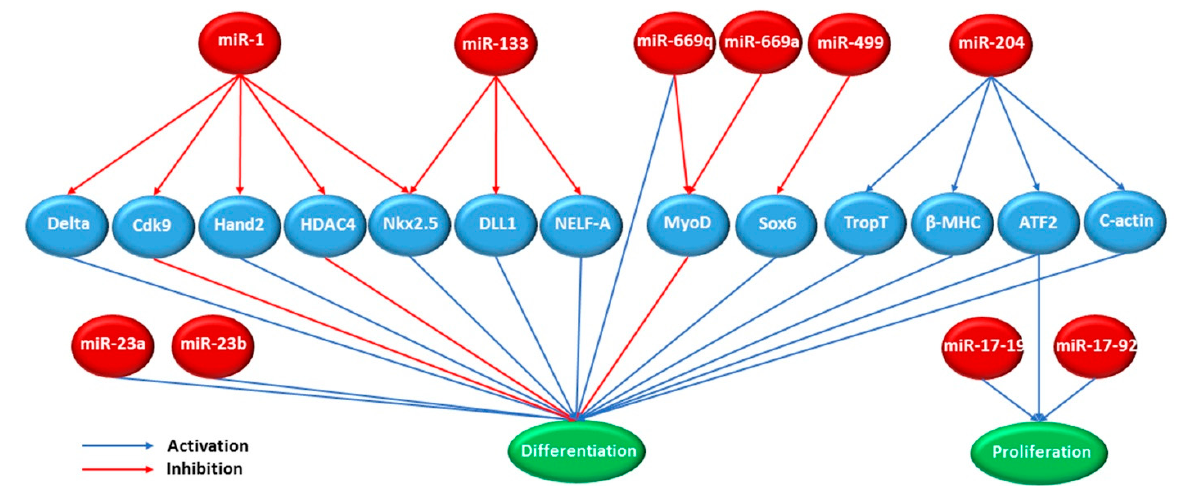
Figure 4. Various miR subtypes (red circle) role in inhibition (red arrows) and activation (blue arrows) of specific tran- scription factors (blue circle), which are responsible for differentiation and proliferation of cardiomyocytes (modified from [160]). For example, increased miR-1 induces differentiation of cardiac progenitor cells by repressing the translation of cdk9. Conversely, increased miR-133 inhibits this process by repressing the translation of DLL1, a transcription factor that promotes the expression of cardiac mesoderm genes.